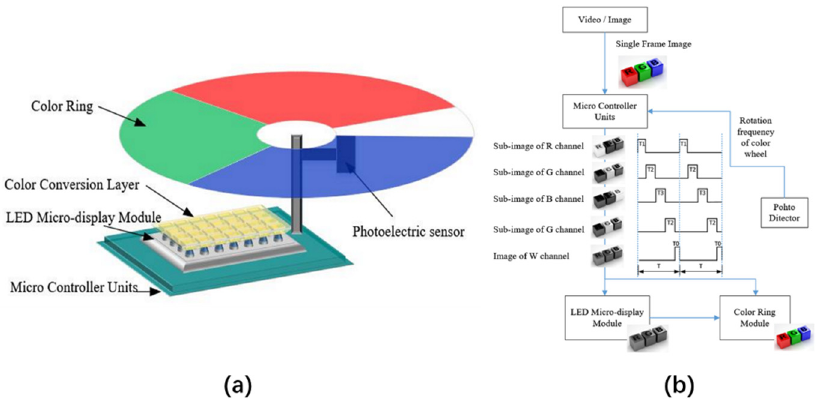
Figure 8. ( a ) Dynamic color filter full-color LED micro-display system structure based on time division multiplexing and ( b ) the working process of the system. Reproduced from [52], with permission from John Wiley and Sons, 2019.